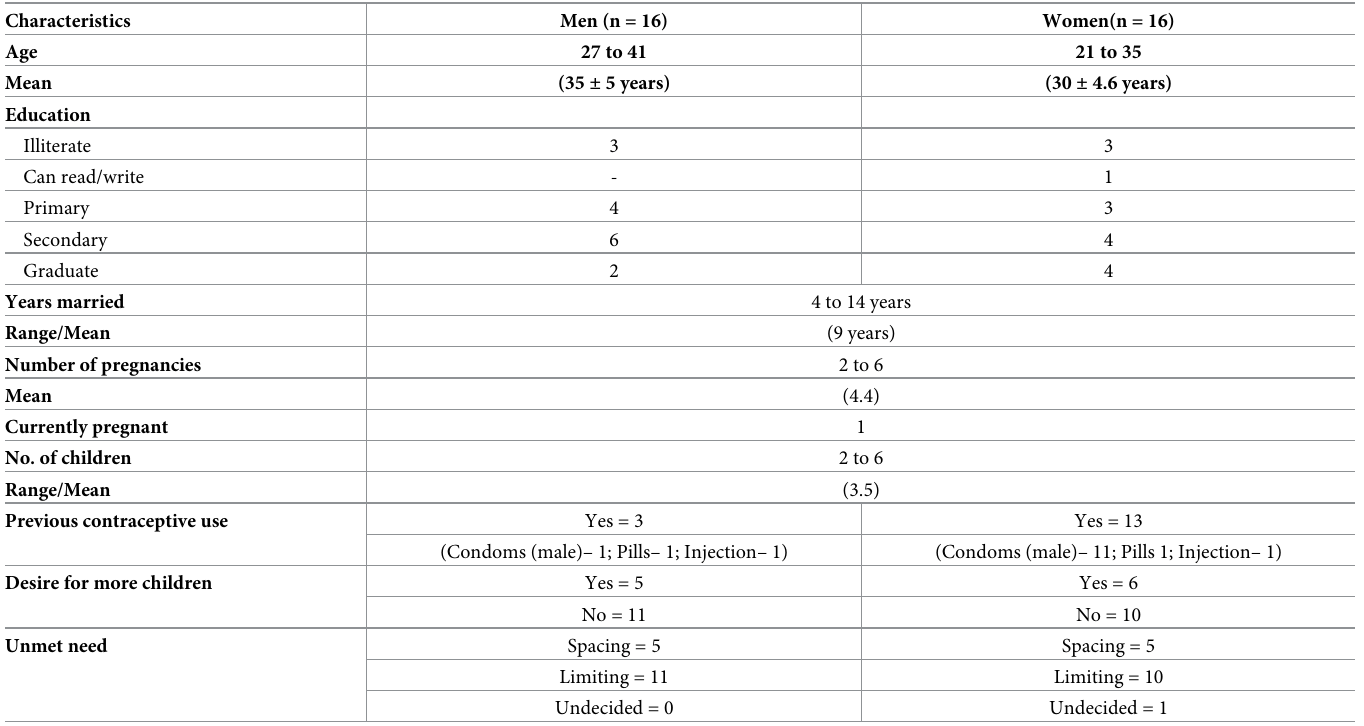
Table 1. Socio-demographic characteristics and contraceptive preferences and use of